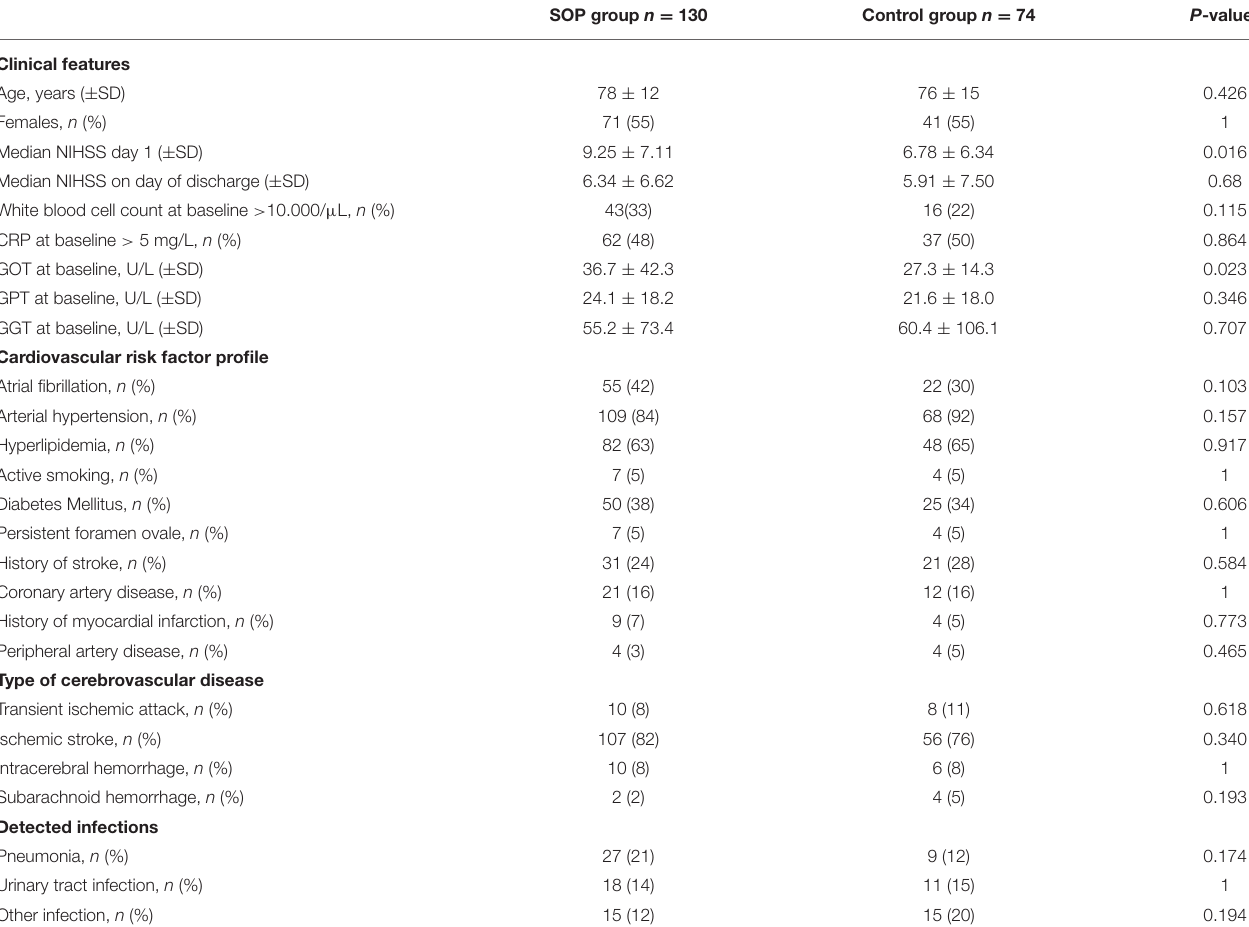
TABLE 1 | Baseline characteristics of